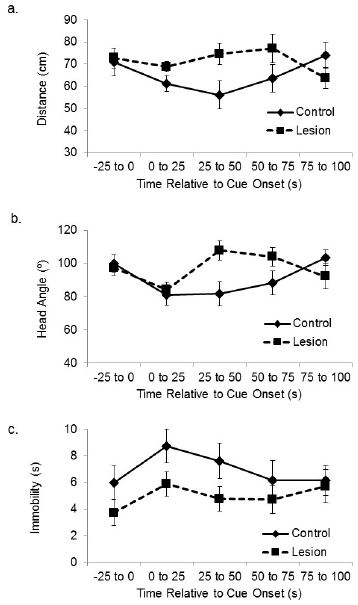
Figure 4. Medial prefrontal cortex (mPFC) and cue-directed orientation. ( a ) The distance between the subjects and the corner of the platform nearest the active speaker is plotted during the sensory preconditioning session exposure to the auditory cue and the immediately preceding baseline period. Control subjects approached the active speaker during the cue more than subjects with lesions to the mPFC; ( b ) The head angle relative to the location of the active speaker during the baseline period and cue exposure is plotted. Control subjects maintained head orientation towards the location of the auditory cue more than subjects with lesions to the mPFC; ( c ) The number of seconds spent immobile during the baseline period and after cue onset is plotted. The difference between the control and lesioned groups in seconds spent immobile was not statistically